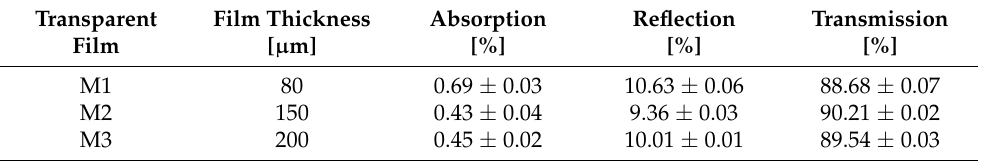
Table 4. Optical properties of all materials at the PTP working wavelength of 1070 nm.